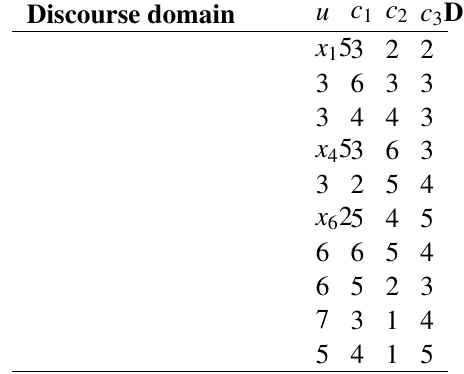
Table 1 Classification attribute set of data